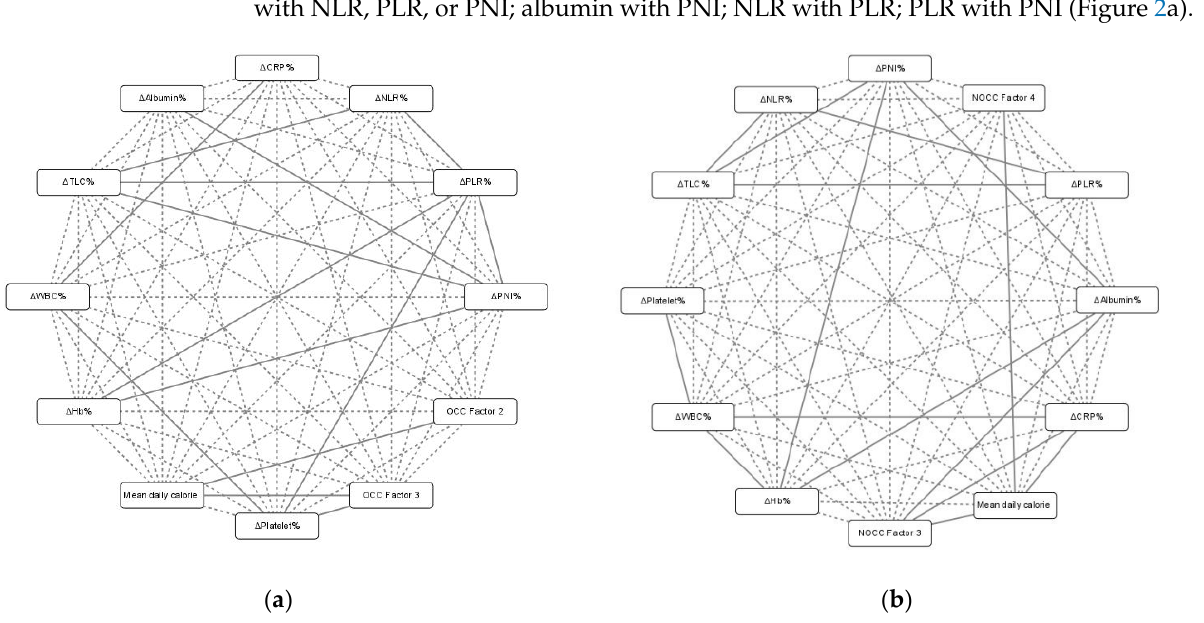
Figure 2. ( a ) Patients with OCC with postoperative adjuvant CCRT; ( b ) patients with NOCC with primary CCRT. Two-dimensional visualization of the correlations between mean daily calorie intake (at least 25 kcal/kg/day) during the CCRT course, treatment interval changes in nutrition–inflammation biomarkers (NIBs) (∆Hb%, ∆WBC%, ∆Platelet%, ∆Albumin%, ∆TLC%, ∆CRP%, ∆NLR%, ∆PLR%, and ∆PNI%), and body composition (OCC Factor 2, OCC Factor 3, NOCC Factor 3, and NOCC Factor 4). OCC, oral cavity cancer; NOCC, non-oral cavity cancer; Hb, hemoglobin; WBC, white blood cell count; TLC, total lymphocyte count; CRP, C-reactive protein; NLR, neutrophil-to-lymphocyte ratio; PLR, platelet-to-lymphocyte ratio; PNI, prognostic nutritional index. ∆ indicates the interval changes in the abovementioned blood NIBs before and after the CCRT course. Individual variables are represented by the nodes, and their associations are represented by the edges (connecting lines). Solid edges indicate significant associations between two variables ( p < 0.05). Dashed edges indicate no correlation between two variables.